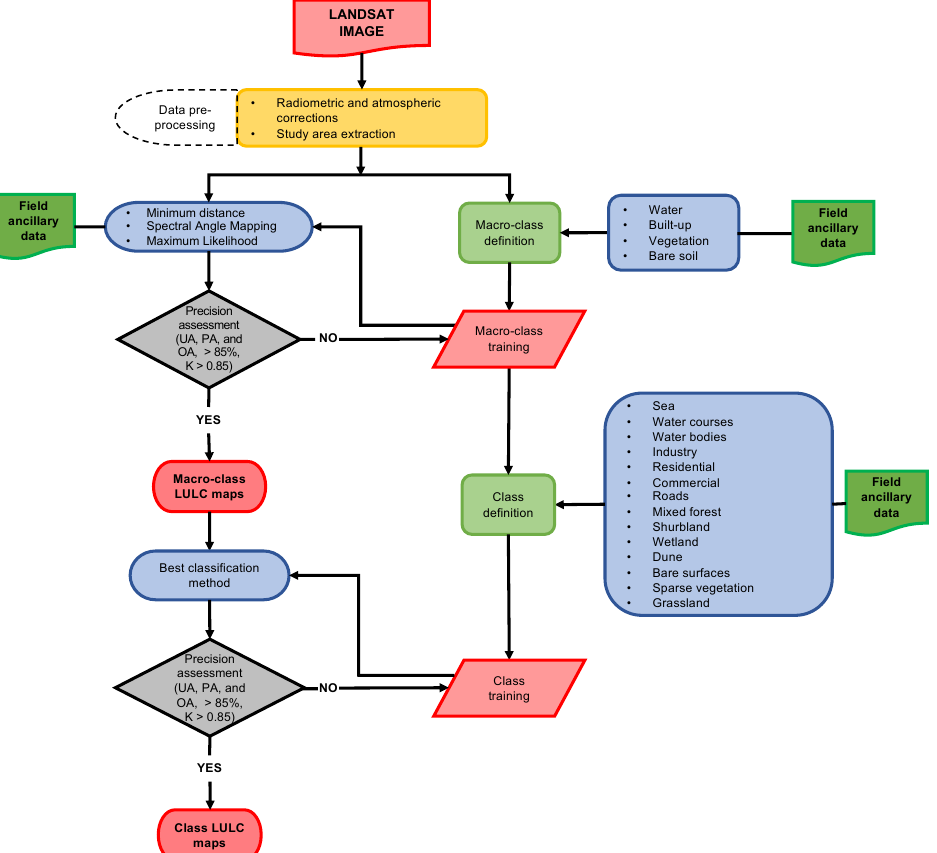
Figure 2. Flow diagram of the LULC classification methodology implemented in the SCP